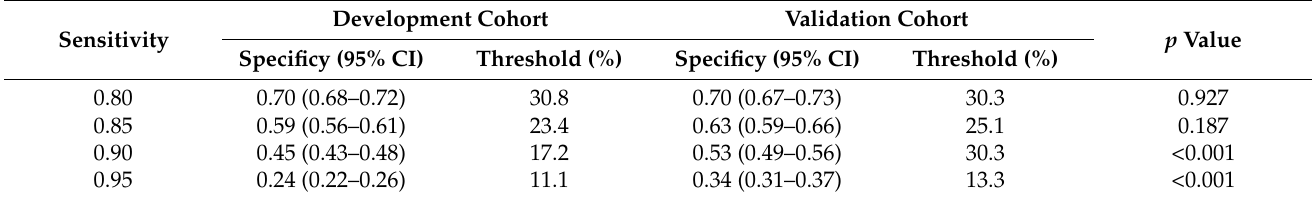
Table 3. Specificities of developed predictive model corresponding to sensitivities of 0.80, 0.85, 0.90, and 0.95 in the development and validation cohorts.